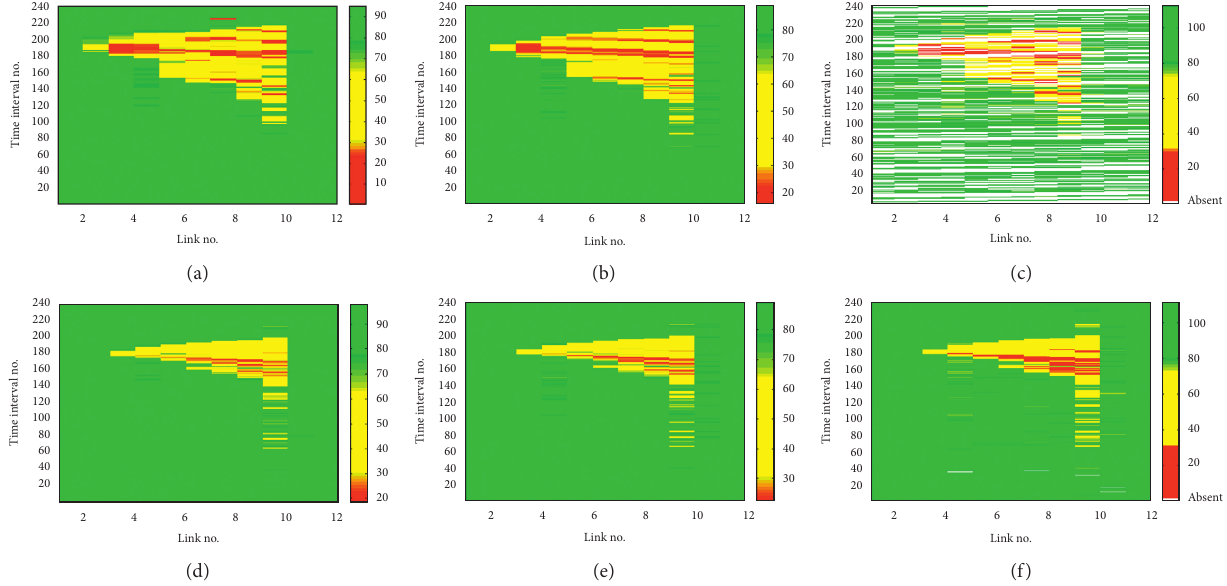
Figure 7: Estimated speeds, the ground-truth speeds, and the CAV speeds in the color map. (a) Estimated speeds with 1% penetration rate of CAVs (km/h). (b) Ground-truth speed when CAVs account for 1% (km/h). (c) CAV speeds with 1% CAVs in mixed traffic (km/h). (d) Estimated speeds with 10% penetration rate of CAVs (km/h). (e) Ground-truth speeds when CAVs account for 10% (km/h). (f) CAV speeds with 10% CAVs in mixed traffic (km/h).